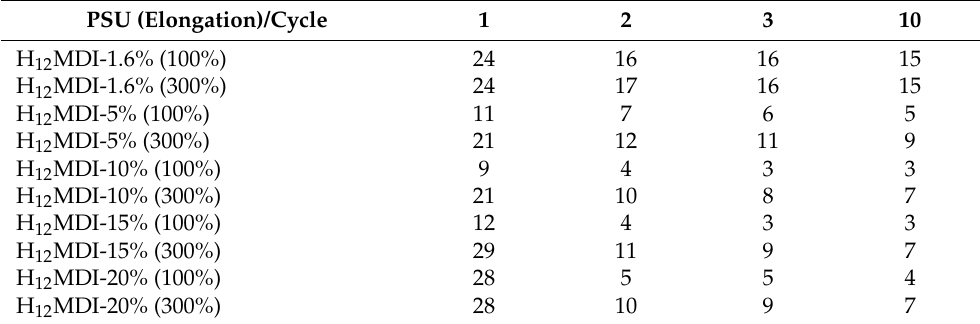
Table 3. Influence of HS content on tensile hysteresis for PSU elastomers synthesized from H 12 MDI with HSs ranging from 1.6% (copolymer) to 20%. The values are given for the first three cycles and the last (10th) cycle at 100% and 300% strain, respectively. The given values are the mean values from three repeated measurements and were rounded to